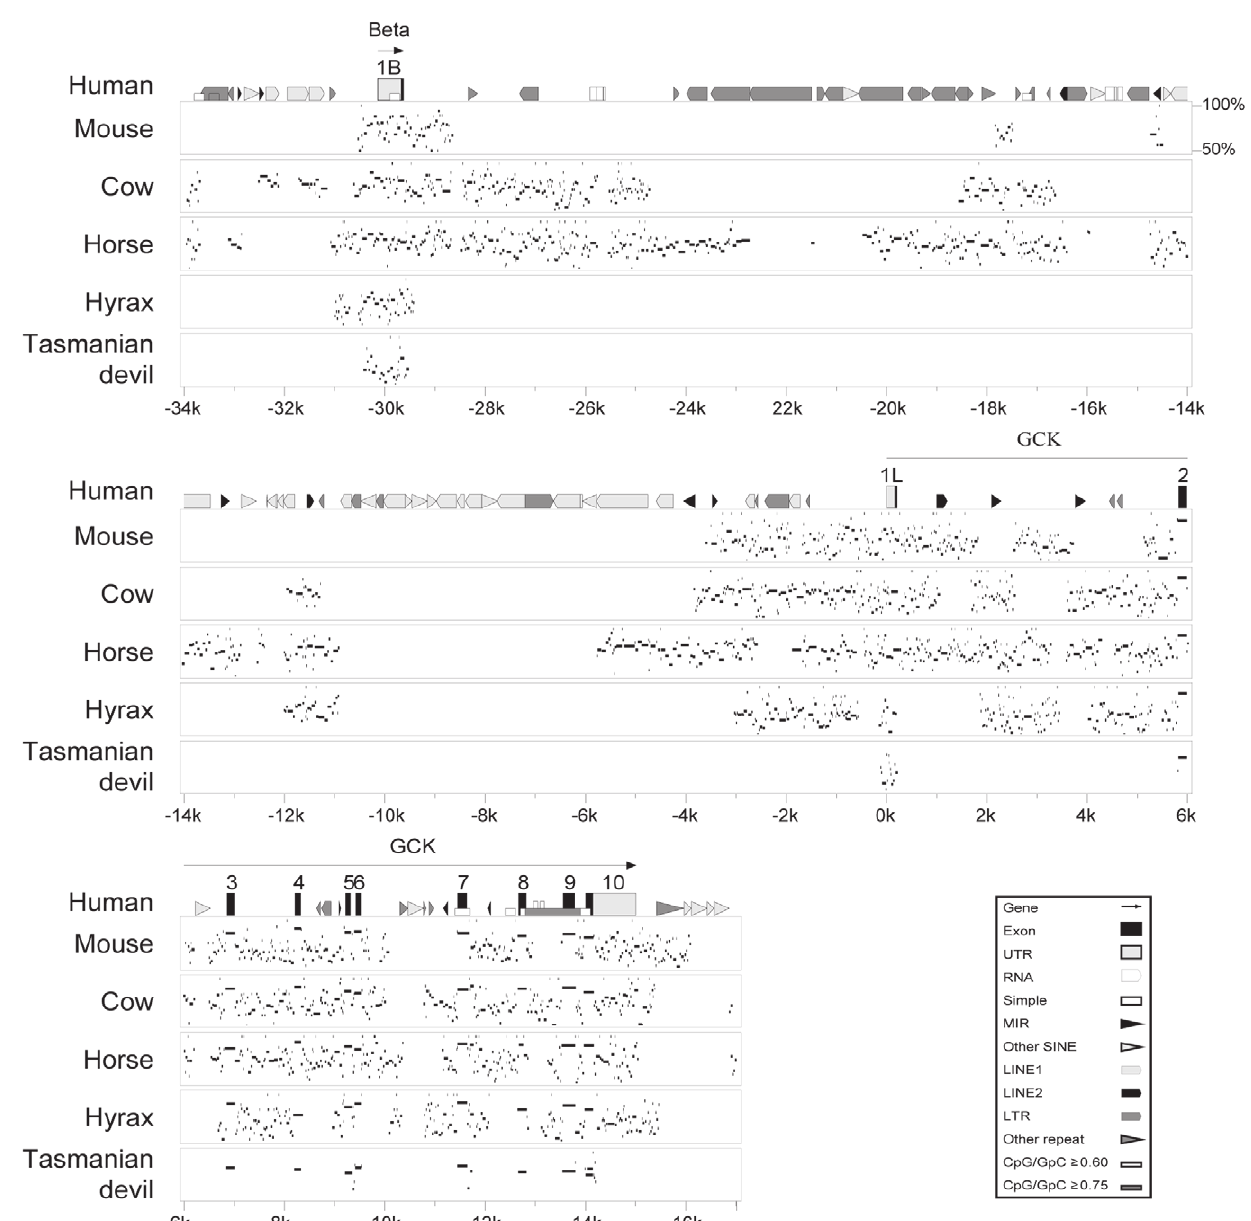
Figure 1. Alignment of glucokinase gene sequences from diverse mammals. A genomic sequence alignment was generated by MultiPipMaker [24,25]. The sequence is numbered (in kilobases, k) from the 5 9 end of the liver-specific transcript, with 5 9 flanking sequence numbered backwards. Exons are represented as tall boxes, and are numbered from the 5 9 end of the transcripts. The arrow, labeled GCK, represents the liver- specific glucokinase transcript. Beta refers to the 1 st exon of the beta-cell-specific GCK transcript, which is spliced to join exon 2. Tissue-specific first exons are labeled as 1B, for the pancreatic beta-cell-specific 1 st exon, and 1L, for the liver-cell-specific 1 st exon. Filled tall boxes are coding exon sequences, while shaded boxes are untranslated sequences. The percentage sequence identity (if above 50%) of the mouse, cow, horse, hyrax, and Tasmanian devil GCK genomic sequences to the human genomic sequence is shown for each species below the human genomic region schematic. Repetitive DNA elements, and sequence shown high GC content are also identified using the symbols shown in box at the lower right. doi:10.1371/journal.pone.0045824.g001 the master sequence (see Fig. S2 as an example), with similar master sequence (in Fig. 1 the master is the human sequence, with the annotation of the human gene and repetitive DNA content sequences confined largely to the coding exons, consistent with shown on the top line) with the similarity of the compared most intron and flanking sequence having limited biological sequence, between 50–100%, indicated for each species. The function and thus not strongly conserved. When comparisons are limited to between genes from placental mammalian species, many sequence from the marsupial Tasmanian devil sequence showed limited similarity to the human genomic sequence (Fig. 1), with of the intron sequences, especially those of introns 2 through 9, similar results found when other genomic sequences were used as show identities greater than 50%, with exon sequences showing